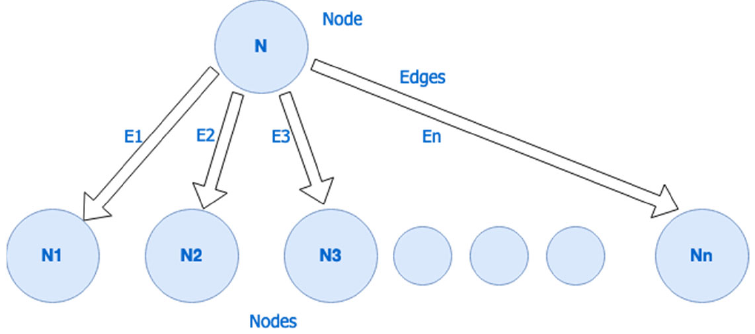
Figure 3. An example of Bayes Network.